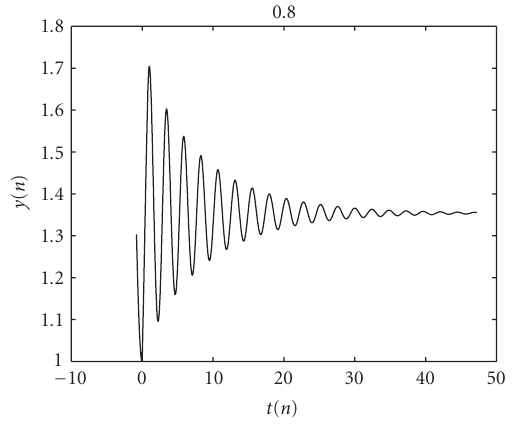
Figure 4.1. The equilibrium of (2.2) is asymptotically stable when τ = 0 . 8.